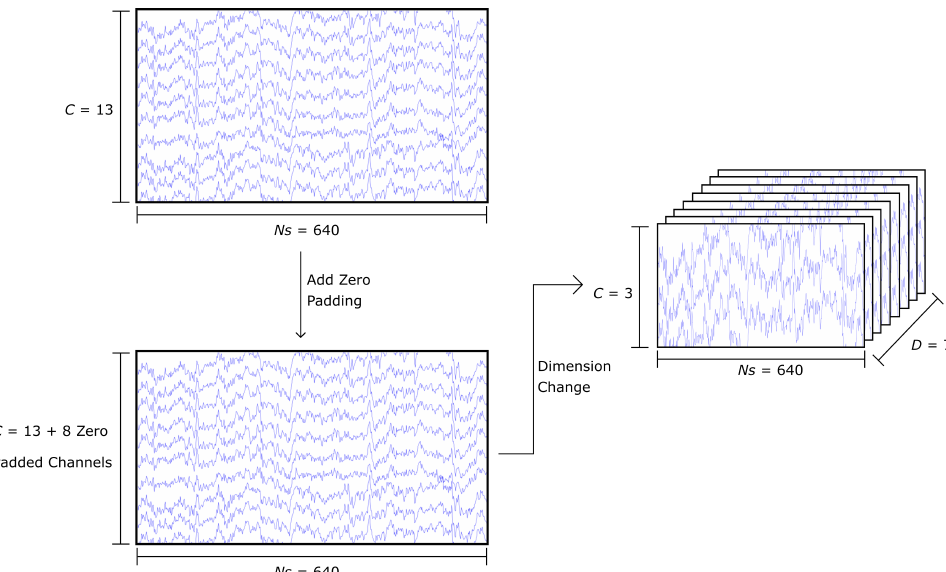
Figure 9. The 13-channel raw EEG signal data preparation for volume representation. Before ar- ranging the signal into a 3D matrix, eight zero-padding arrays are introduced into the sample to be able to generate a 3 × 3 × 3 matrix, where C indicates the number of channels, Ns indicates the number of samples per channel, and D indicates the number of depth layers in the 3D matrix of the volume